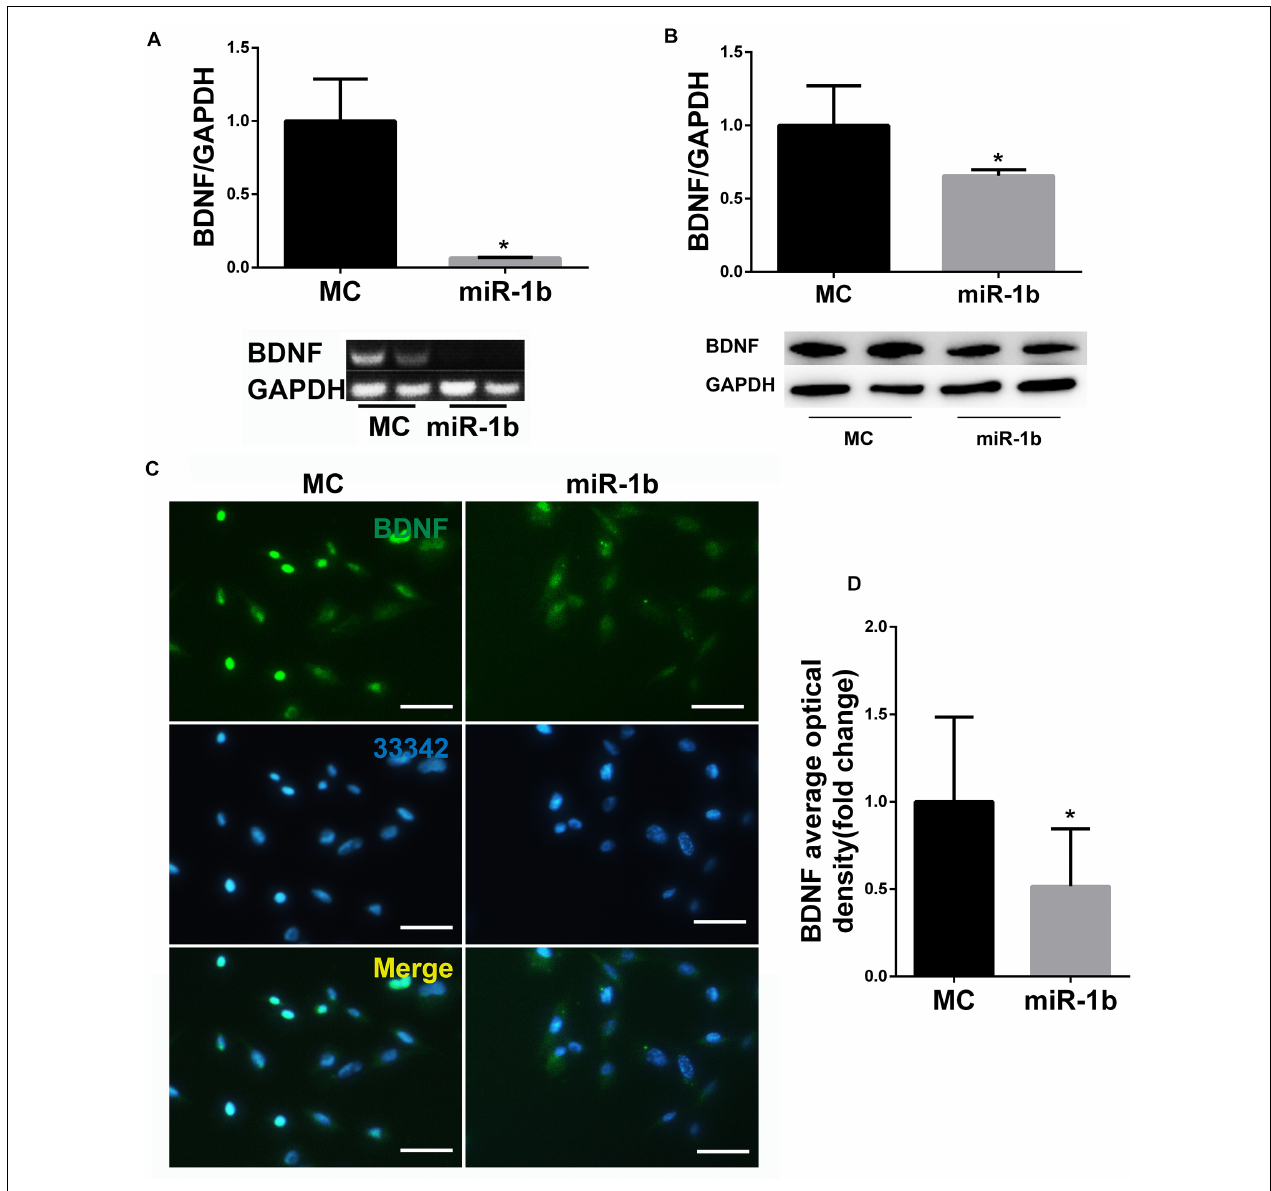
FIGURE 2 | miR-1b targeted brain-derived neurotrophic factor (BDNF) in Schwann cells (SCs). (A) BDNF microRNA (miRNA) expression in RSC96 was detected by PCR. * P < 0.05 versus the MC group. (B) BDNF protein expression was detected by Western Blot. * P < 0.05 versus the MC group. (C) Immunofluorescence staining of BDNF. Scale bar = 25 µ m. (D) The mean fluorescence optical density of BDNF was analyzed. * P < 0.05 versus the MC